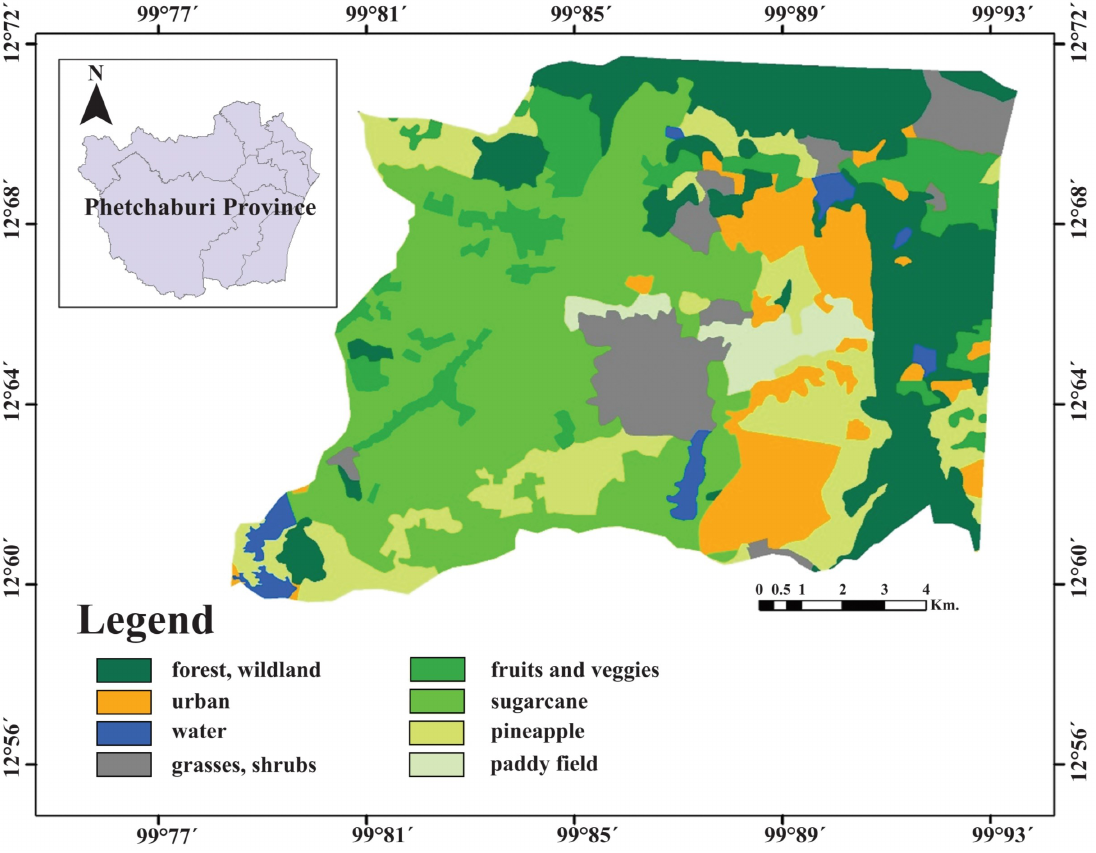
Figure 4. Agriculture areas in the study area